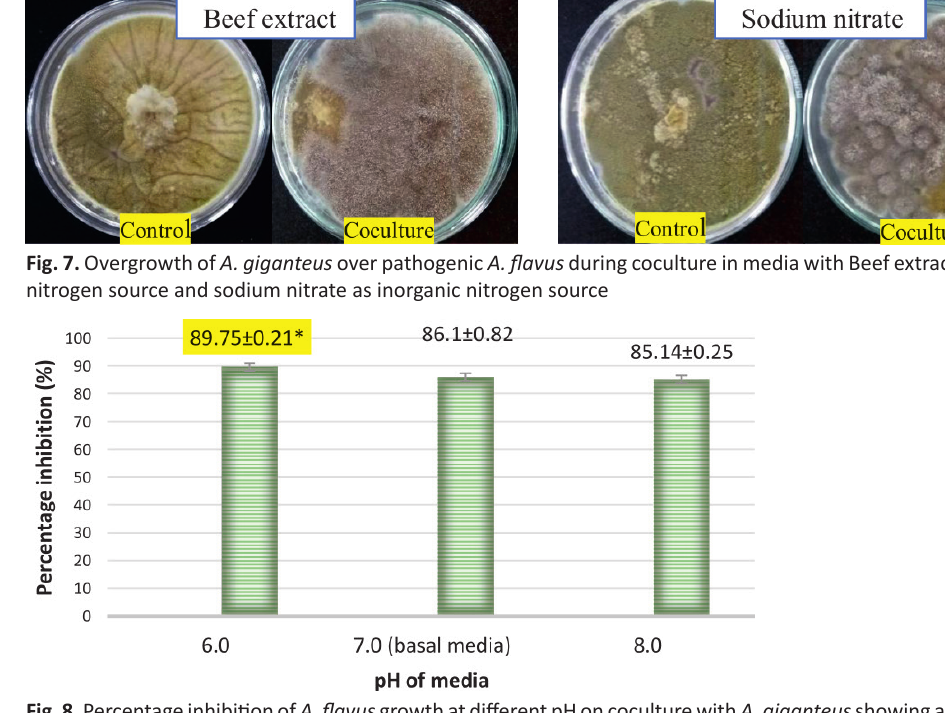
Fig. 8. Percentage inhibition of A. flavus growth at different pH on coculture with A. giganteus showing an increasing trend in inhibition as the pH decreased. Inhibition percentage = (ControlTest/ Control) x100. Values are represented as Mean ± SD (n=3). *Value is statistically significant at P ≤ 0.05 compared to normal pH 7.0